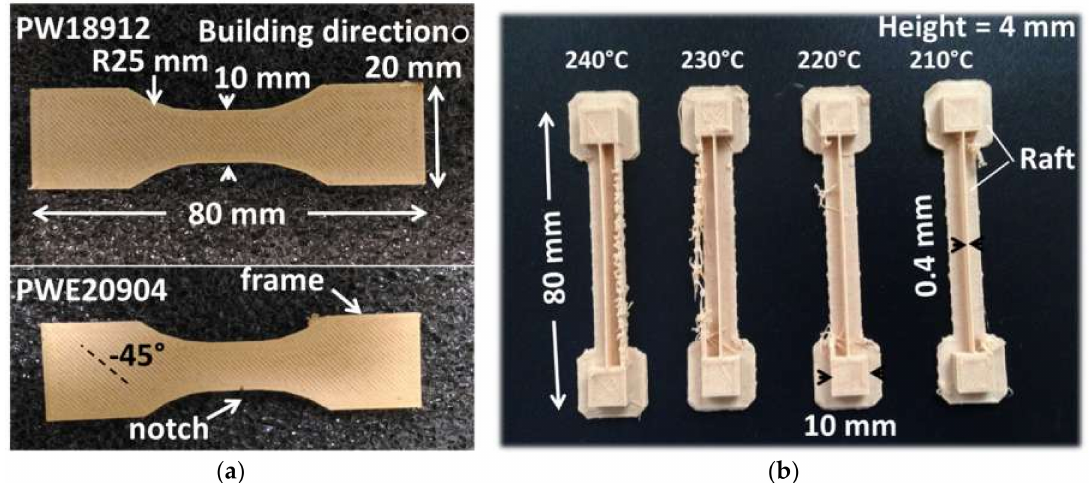
Figure 2. ( a ) Unnotched and notched tensile specimens printed using wood-PLA / PHA filament. Notches were performed after printing. ( b ) Specimen considered for thermal analysis under di ff erent printing